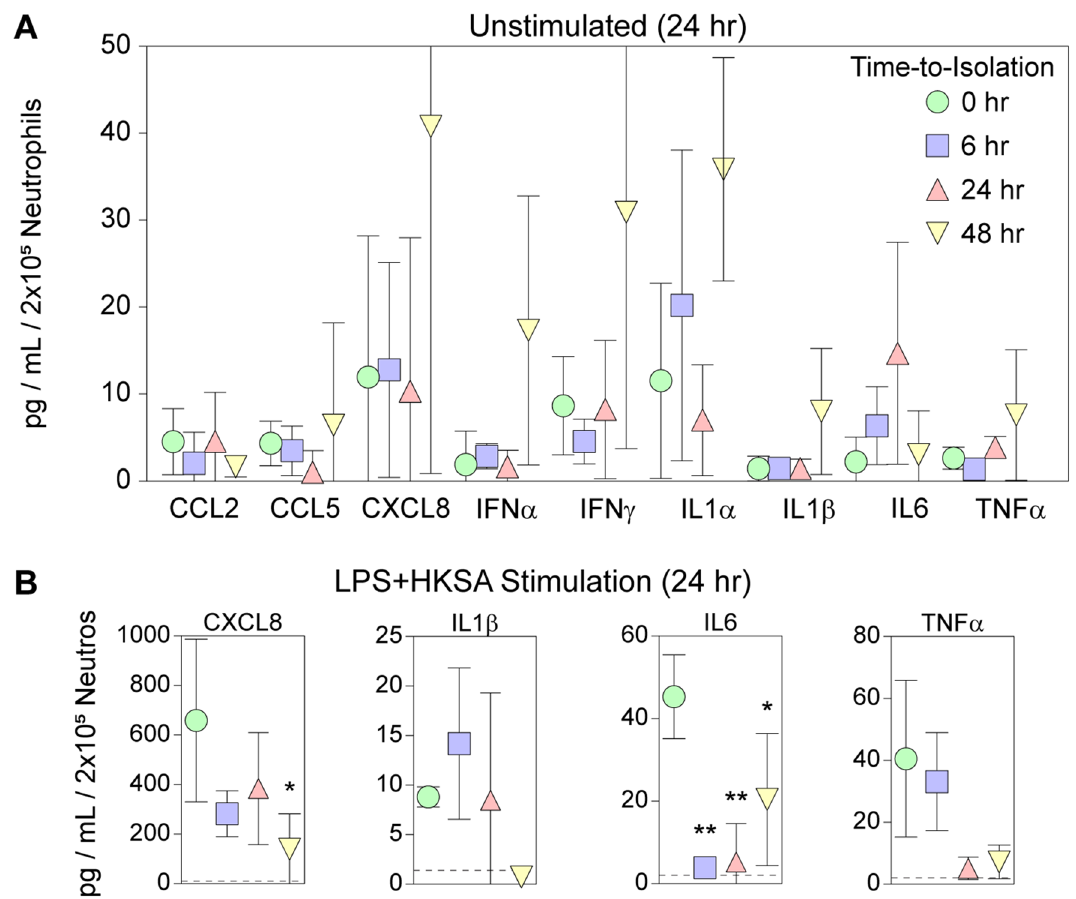
Figure 6. Spontaneous release of inflammatory factors is maintained in neutrophils from shipped whole blood but stimulated responses are quickly abrogated. Neutrophils isolated from blood held for 0, 6, 24, or 48 h were either incubated for 24 h in the absence of stimulation ( A ) or were incubated for 24 h with a cocktail of LPS and HKSA ( B ). Inflammatory cytokines and chemokines released into the supernatant were quantified by multiplex cytometric bead array. ( A ) Relative to neutrophils isolated from fresh blood, there were no outstanding changes in spontaneous release of factors from neutrophils isolated from shipped blood. ( B ) However, even neutrophils isolated from blood held for 6 h at ambient temperature showed loss of stimulated CXCL8, IL6, and TNFα release, though only CXCL8 in the 48 h group and IL6 in the 6, 24, and 48 h groups reached significance. CCL2, CCL5, IFNα, IFNγ, and IL1α were not released in response to LPS + HKSA in neutrophils from any timepoint. Symbols are color-coded as in the legend of ( A ). Each symbol represents the mean of 3 individual healthy donors; error bars show the 95% confidence limits. Analyte levels were normalized to pg per mL per 2 × 10 5 neutrophils. Dashed lines in ( B ) represent spontaneous release level from the 0 h sample. Each analyte timecourse was assessed by one-way ANOVA; * indicates P < 0.05 vs 0 h and ** indicates P < 0.01 by Dunnett’s pairwise